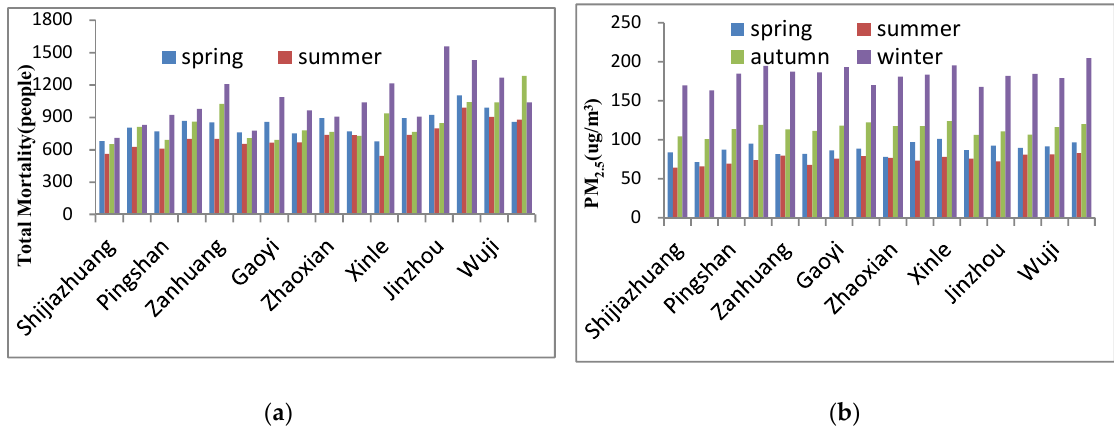
Figure 1. Seasonal distribution of the PM 2.5 concentration (particulate matter with a diameter equal or lower than 2.5 micrometers) ( a ) and circulatory system deaths ( b ) in Shijiazhuang from 2014 to 2016.